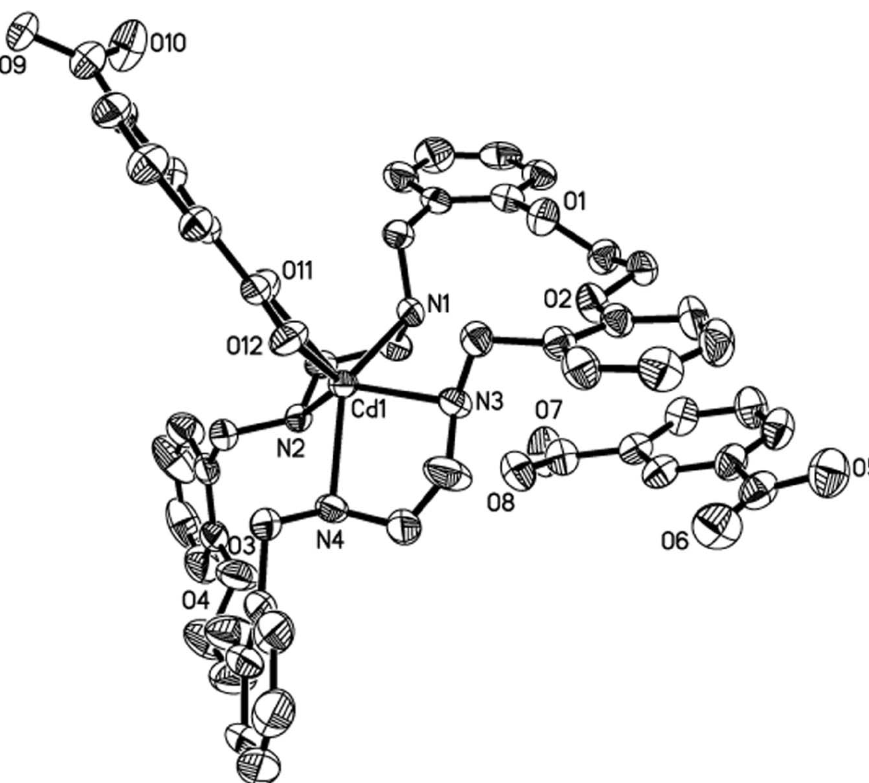
Figure 1 Molecular structure of the title compound. Displacement ellipsoids are drawn at the 30% probability level. H atoms have been omitted for